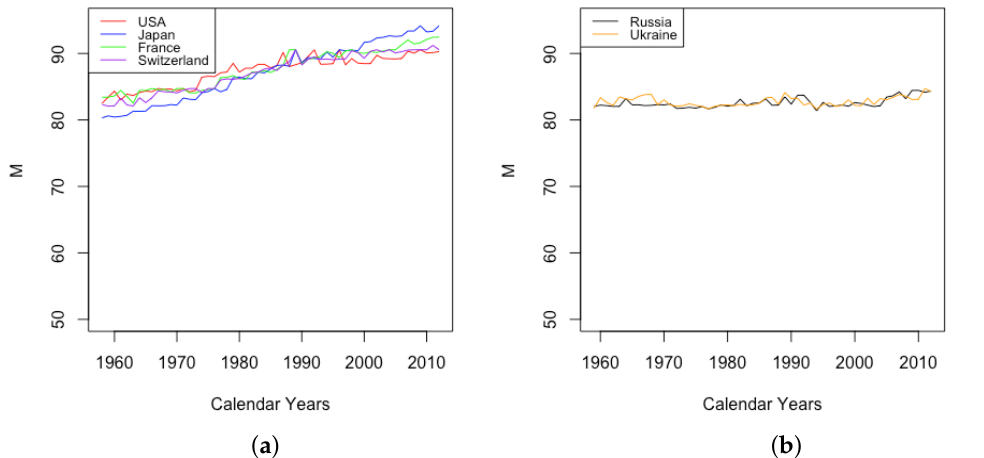
Figure 15. ( a ) The modal age M for females in HLE countries. ( b ) The modal age M for females in ILE